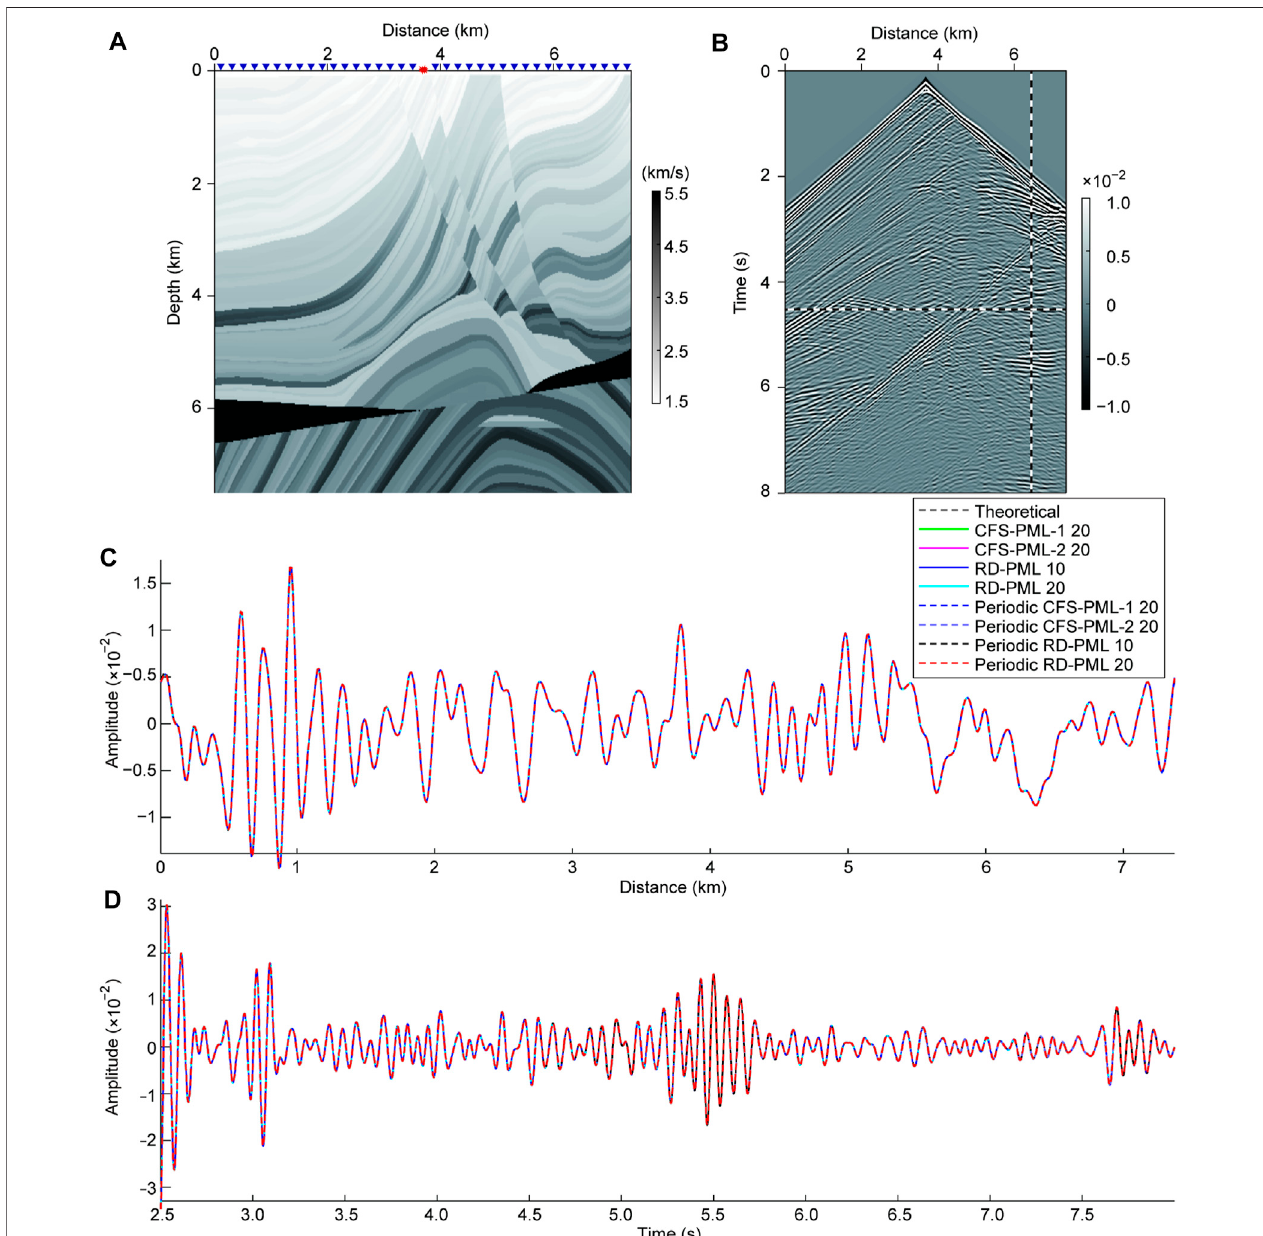
FIGURE10| Numericaltestonaheterogeneousmodel. (A) Modi fi edMarmousimodel. (B) Shotrecordsbythereceiversalongthehorizontallineofbluetrianglesin (A) . (C) and (D) are the waveforms along the horizontal dashed line and the vertical dashed line in (B) , respectively.